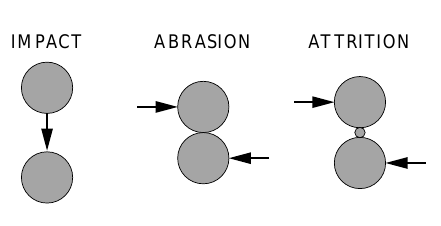
Fragmentation Mechanisms and the Resultant Size Distri-